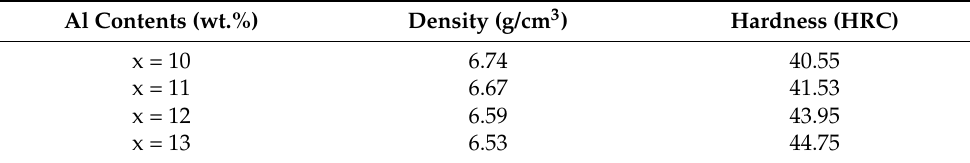
Table 2. Density and hardness of Fe-25Mn- x Al-8Ni-C alloy with different Al contents. Al Contents